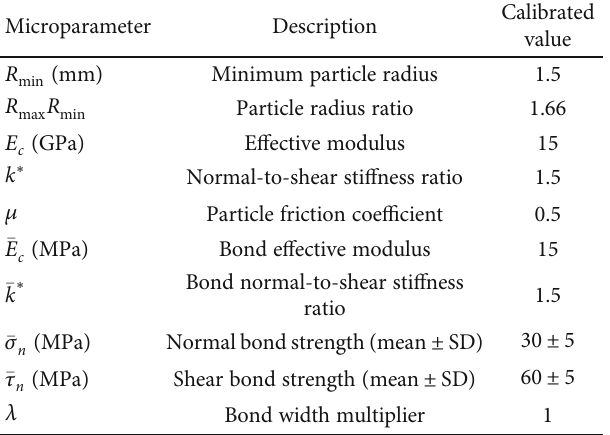
Table 1: Microparameters of the calibrated PFC3D model.